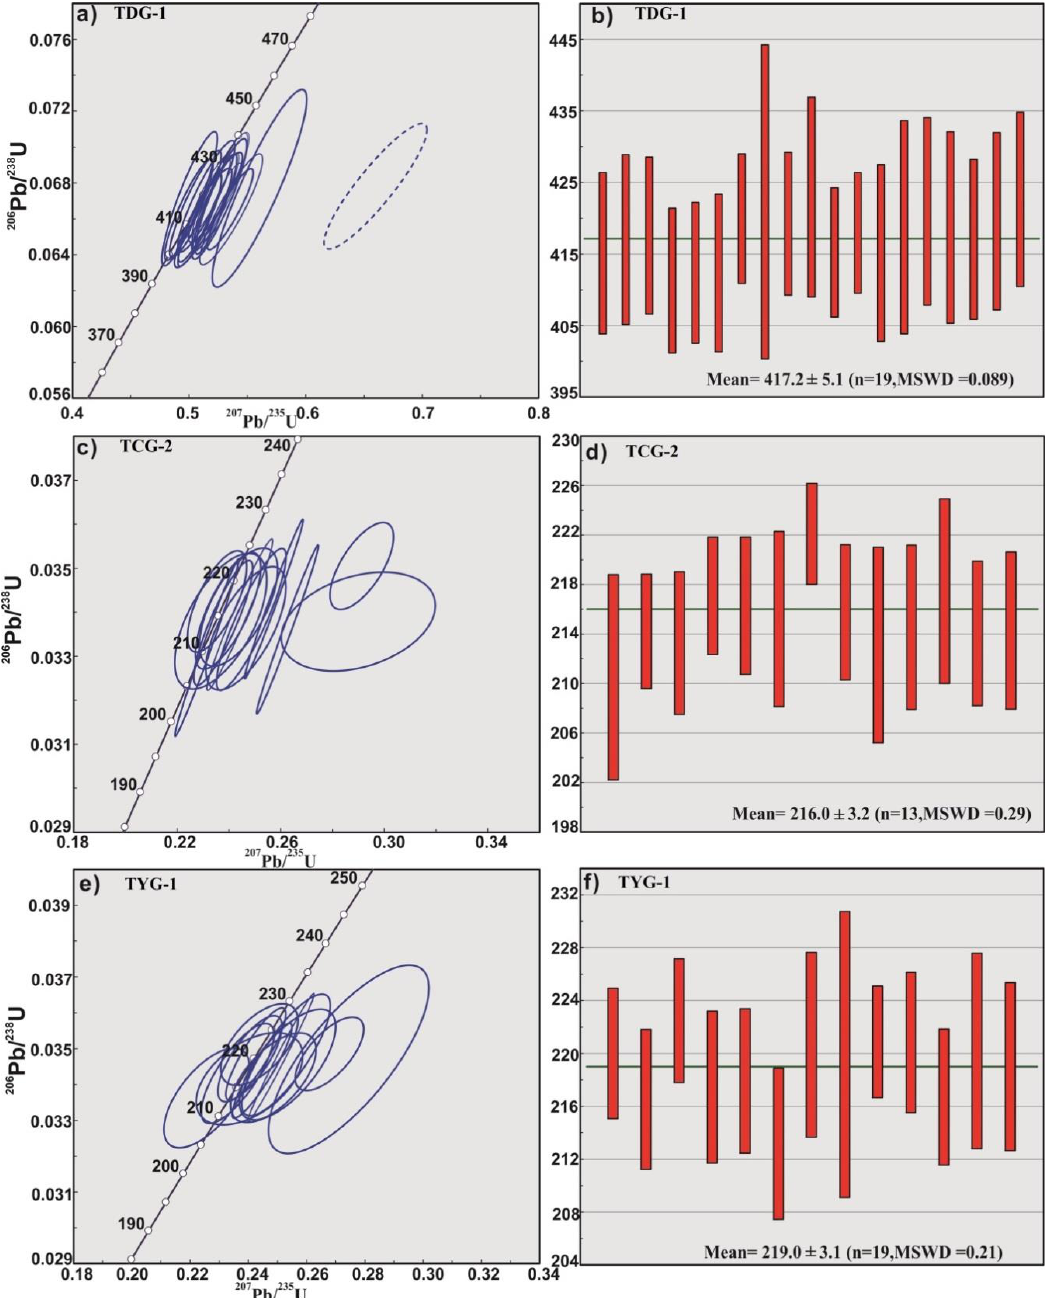
Figure 10. U-Pb zircon concordia diagrams ( a , c , e ) and their weighted mean values ( b , d , f ) for Beidao (TDG-1), Caochuanpu (TCG-2), and Yuanlongzhen (TYG-1), granites, respectively. Our newly obtained U-Pb zircon age data indicate that the magma of these older (e.g., Beidao) and younger (e.g., Caochuanpu and Yuanlongzhen) granites formed during Early Devonian (Lochkovian) and Late Triassic (Norian) due to the subduction of the oceanic lithosphere from the proto-Tethyan (Figure 11a) and the Paleo-Tethyan Qinling (Figure 11b), respectively. Based on trace element geochemistry, it can be stated that the majority of zircon grains from the three granitoids display slightly different geochemical characters in the chondrite normalized REE diagrams (values from [60]) (Figure 8c,d). Total REE contents of zircons of the Early Devonian Beidao granite (TDG-1) range from 368 to 759 ppm (Table 4), whereas U and Th content vary from 500 to 1043 and 47 to 169 ppm, respectively (Table 3). The Th/U ratios vary between 0.09 and 0.22